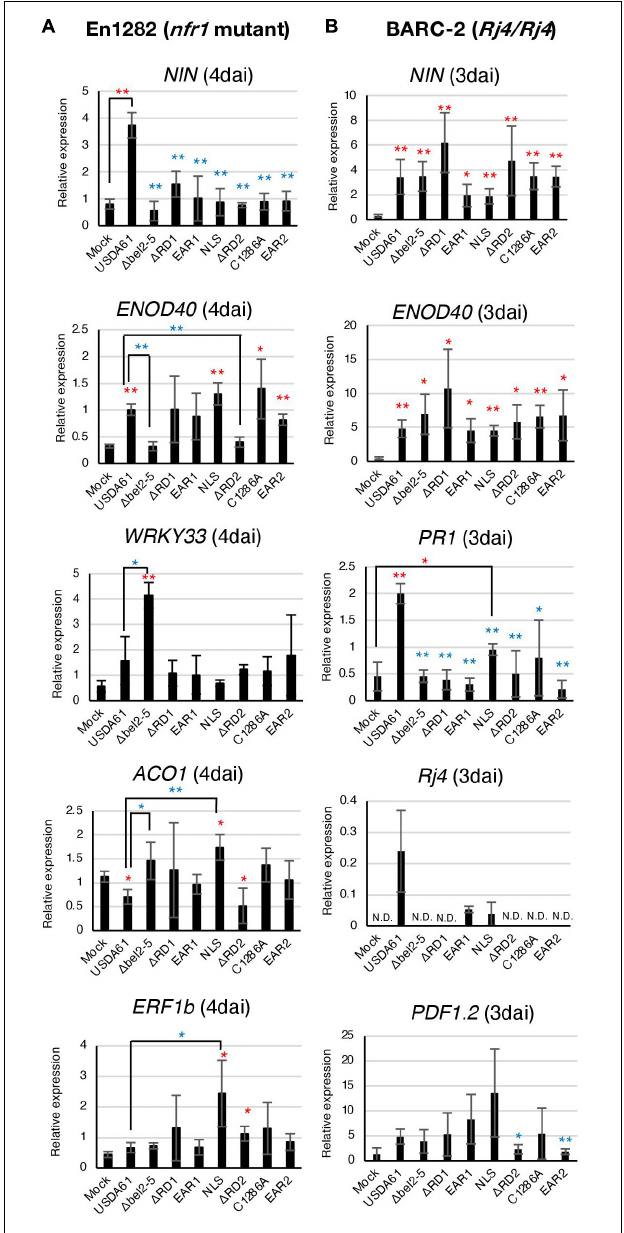
FIGURE 2 | qRT-PCR analysis of soybean defence- and symbiosis-related genes in roots of En1282 (A) and BARC-2 (B) inoculated with the B. elkanii USDA61 wild-type and the bel2-5 deletion mutant and its derivatives (substitutions or deletions). RNA was isolated from the roots of En1282 and BARC-2 at 4 and 3 days after inoculation (dai), respectively. The expression level of each gene was normalized to that of the SUBI2-2 gene. The values represent the mean ± SD ( n = 3–4 independent soybean roots) (A,B) . Statistical analyses (Student’s t -test) were performed for comparison of each inoculation with the mock control (water) (red asterisk) or wild-type USDA61 (blue asterisk). * P < 0.05; ** P < 0.01 (A,B) . USDA61, Bradyrhizobium elkanii wild-type; (cid:49) bel2-5 , bel2-5 knockout mutant; (cid:49) RD1, repeat domain I deletion mutant; BERD1; EAR1, amino acid substitution mutant of the EAR1; BEEAR1; NLS, amino acid substitution mutant of the NLS; BENLS; (cid:49) RD2, repeat domain 2 deletion mutant; BERD2; C1286A, amino acid substitution mutant of the ULP domain; BEC1286A; and EAR2, amino acid substitution mutant of the EAR2;